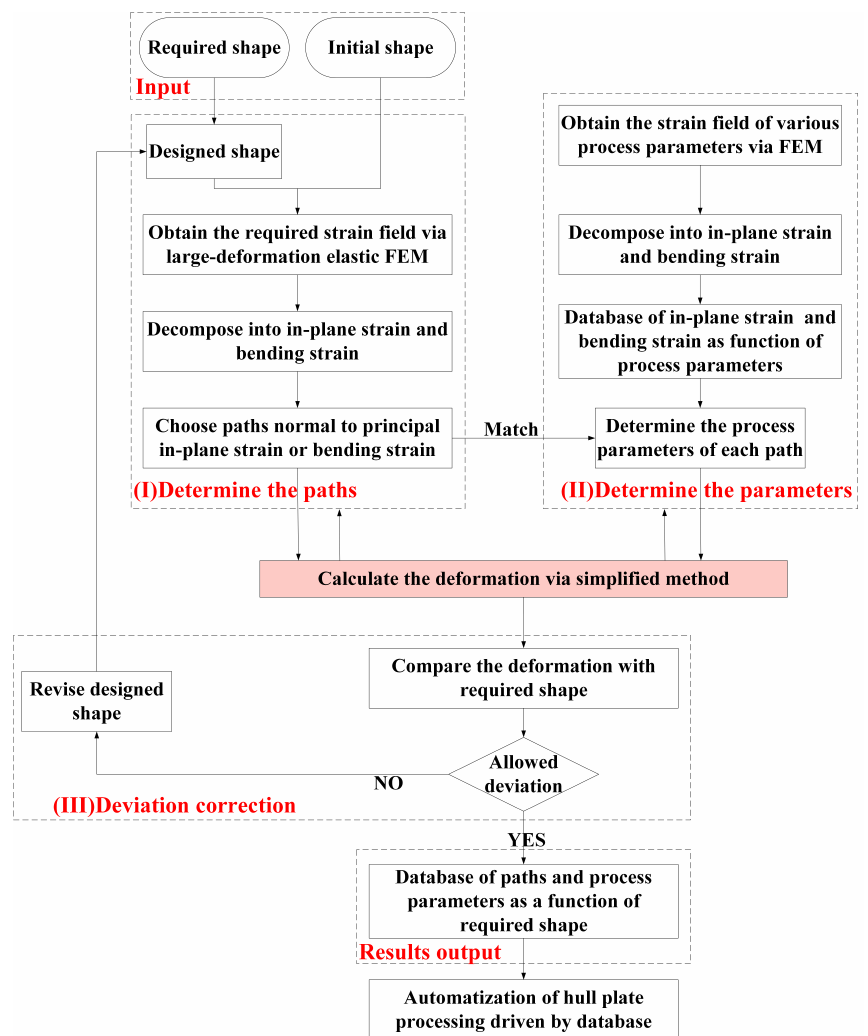
Figure 1. Formation procedure for the automated local line rolling forming driving data of complex curvature plates for